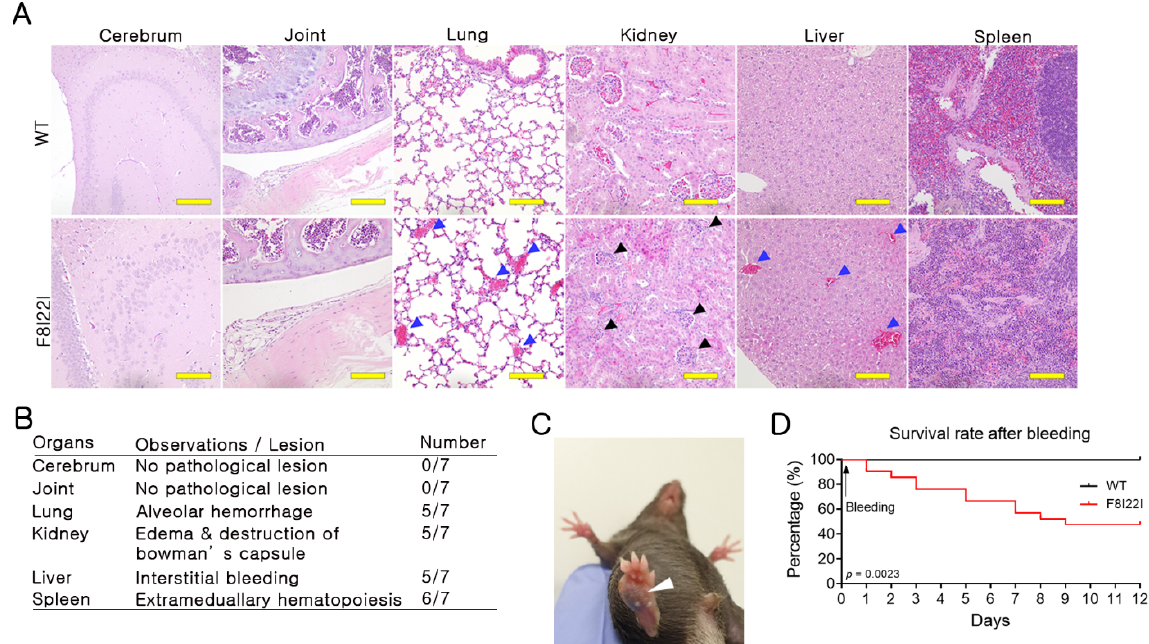
Figure 4. Hemophilia phenotype of F8I22I. ( A , B ) Histological analysis in the cerebrum, joint cavity, lung, kidney, liver, and spleen of WT and F8I22I. Black triangles indicate an edematous lesion in the kidney, and blue triangles indicate bleeding. Scale bar, 100 μ m. ( C ) Macroscopic observation of subcutaneous bleeding in the F8I22I. ( D ) Survival rate was analyzed in WT and F8I22I for 12 days after external bleeding (WT: n = 13, F8I22I: n = 21) .